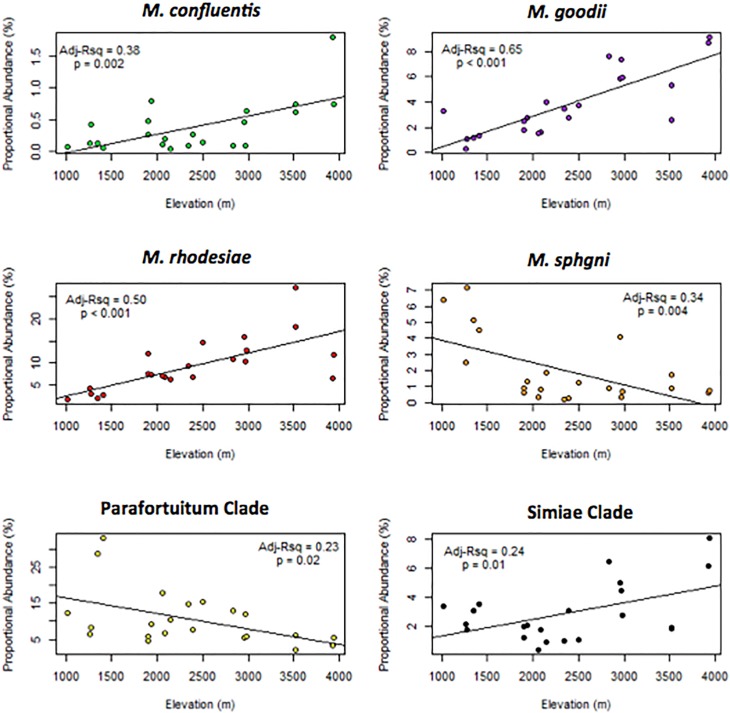
The effect of elevation on proportional abundance of soil mycobacteria.Linear regression of the proportional abundance mycobacteria in soil against elevation.